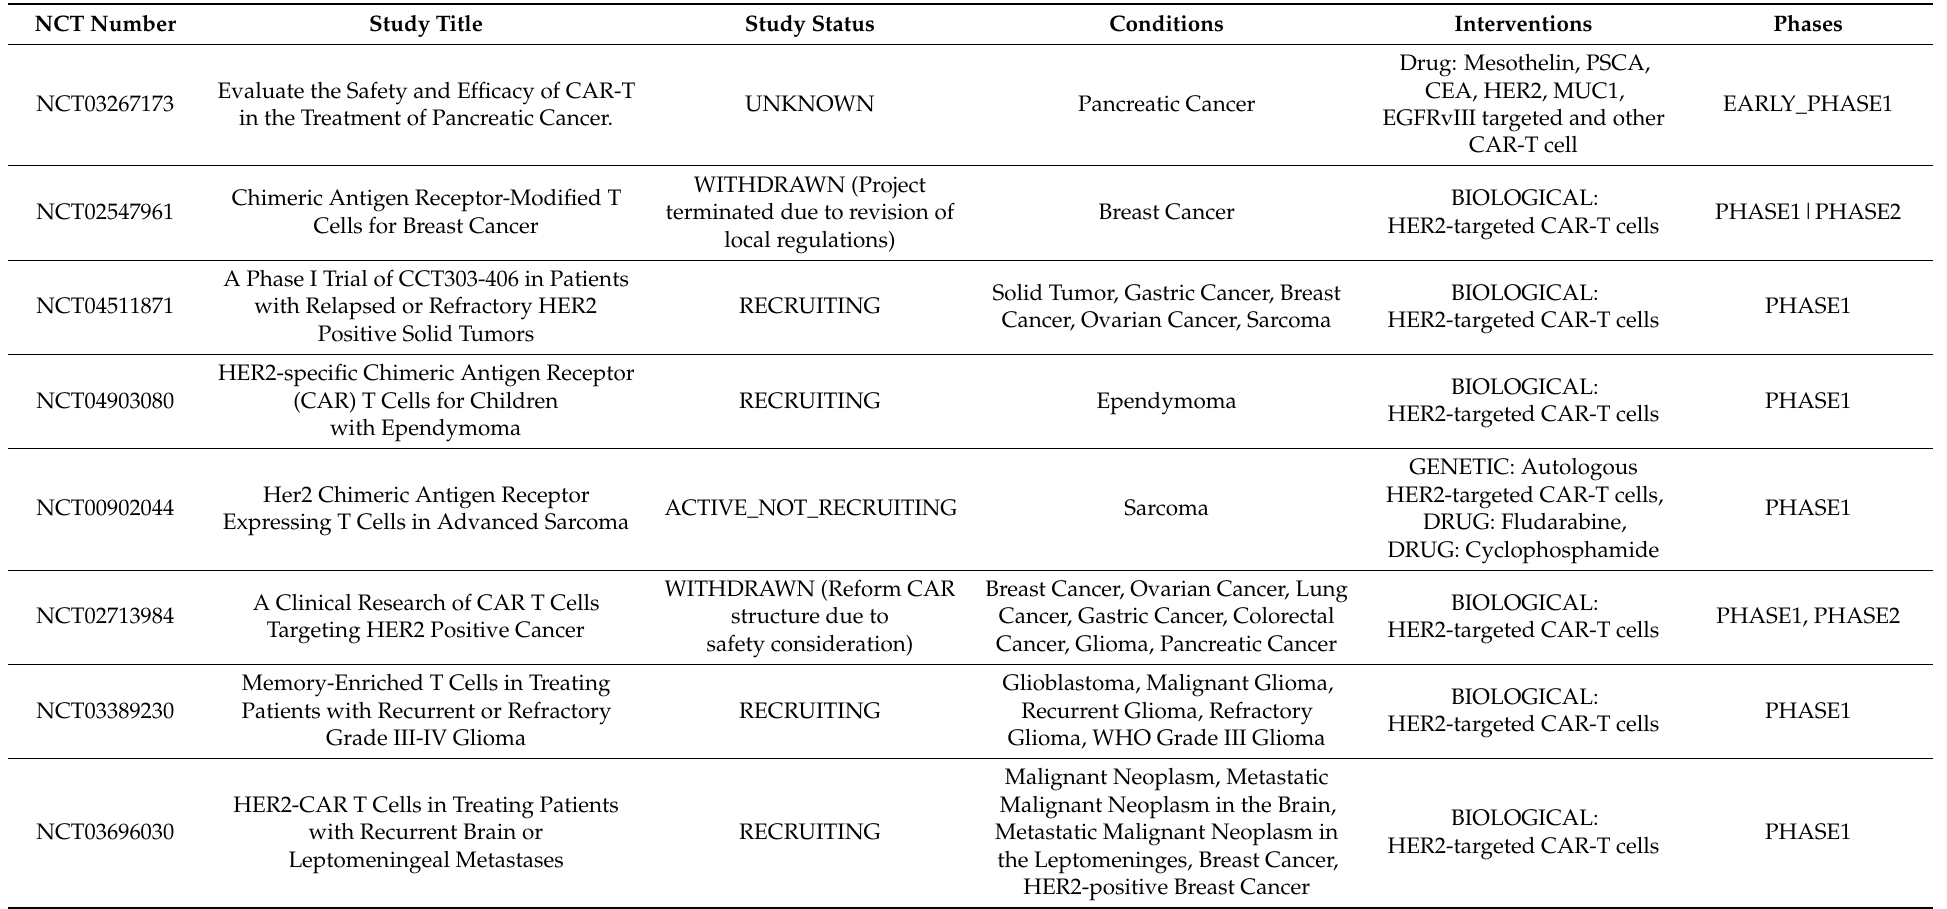
Table 2. Clinical trials with CAR-T-cell therapy for HER2-positive tumors: (clinicaltrials.gov, accessed on 12 October